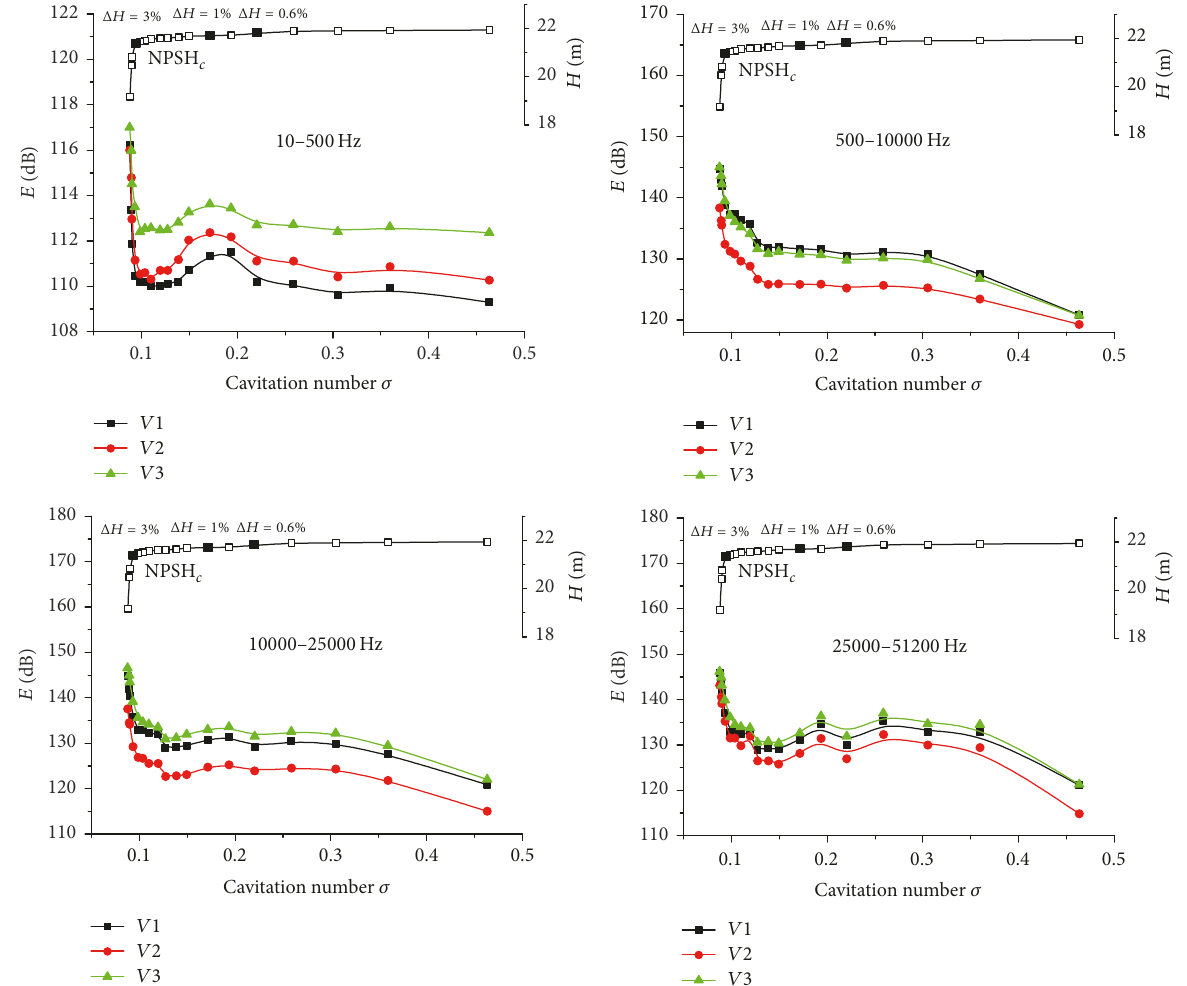
Figure 9: Total vibration energy versus cavitation number at the nominal flow